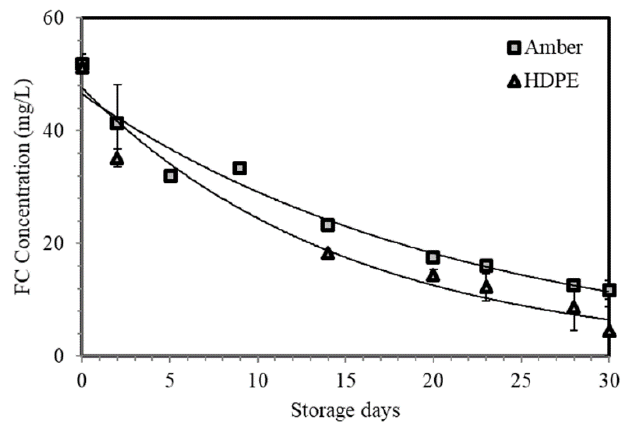
Figure 6. FC distribution of ESW stored in both bottles throughout the 30-day storage period